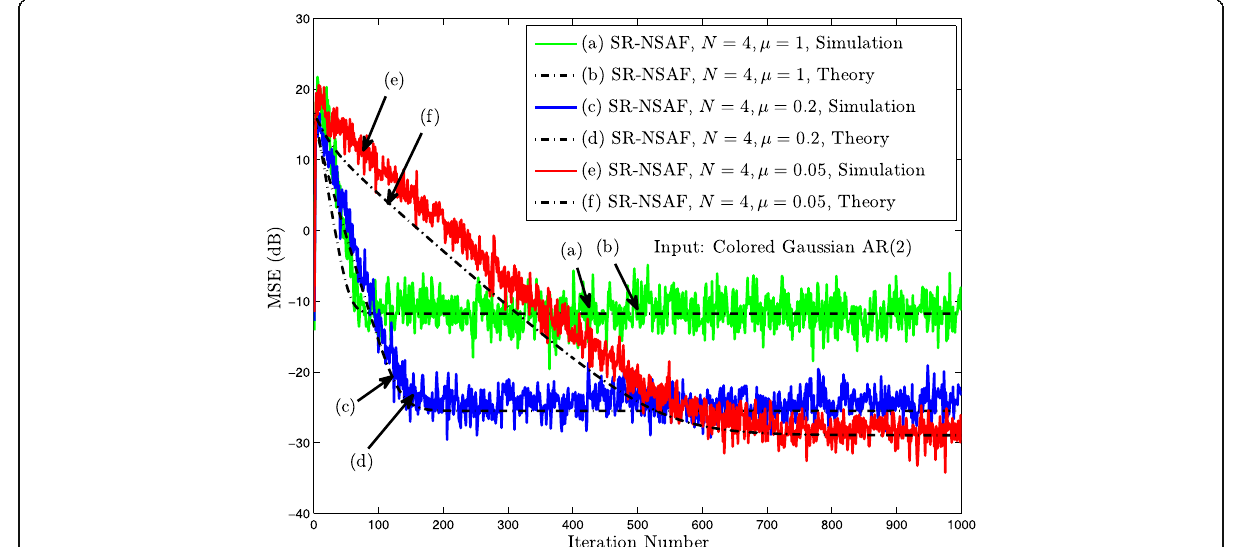
Fig. 20 Simulated and theoretical MSE learning curves of SR-NSAF for different values of